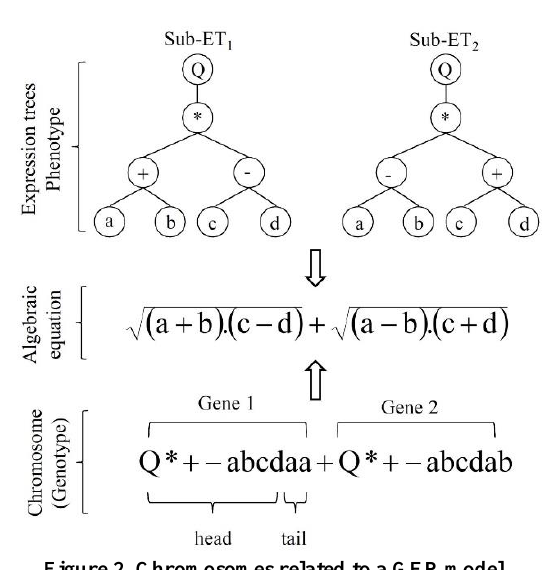
Figure 2. Chromosomes related to a GEP